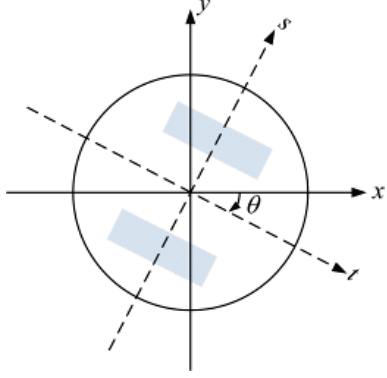
Figure 3. The coordinate system for the symmetry